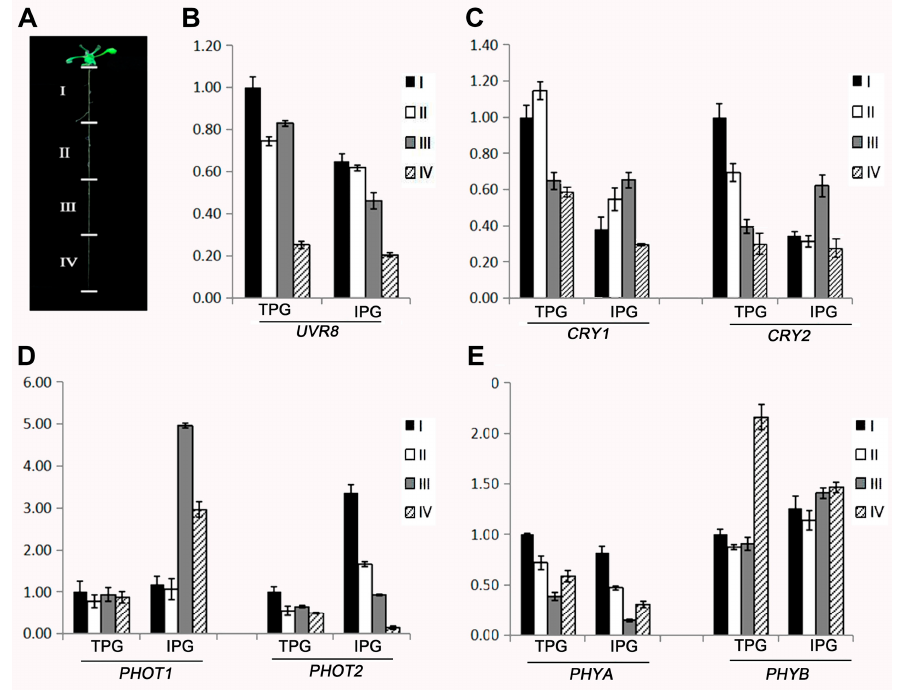
Figure 4. Expression patterns of seven plant photoreceptors in Arabidopsis roots grown in TPG and IPG conditions. ( A ) An image showing four sections from the roots of Arabidopsis with 1.5 cm length